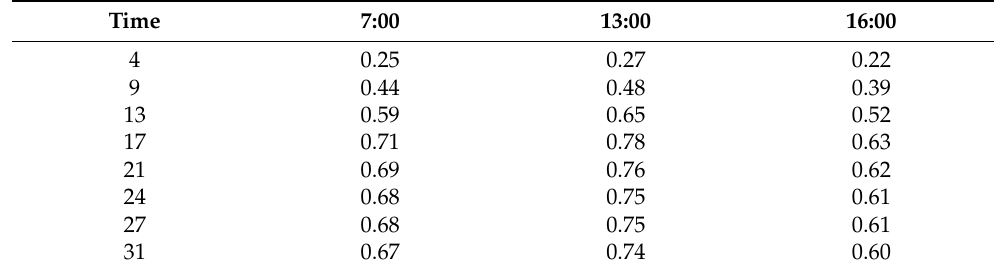
Table A5. The magnitude of the 13th harmonic current of each harmonic source at different times